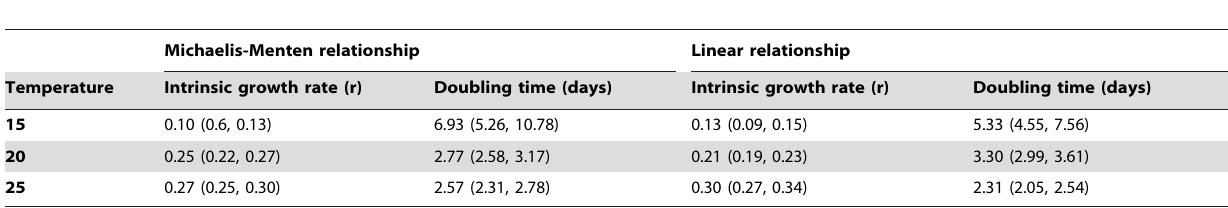
Table 2. Estimated intrinsic growth rate and doubling time for the modeled Michaelis-Menten and linear relationships between temperature and growth